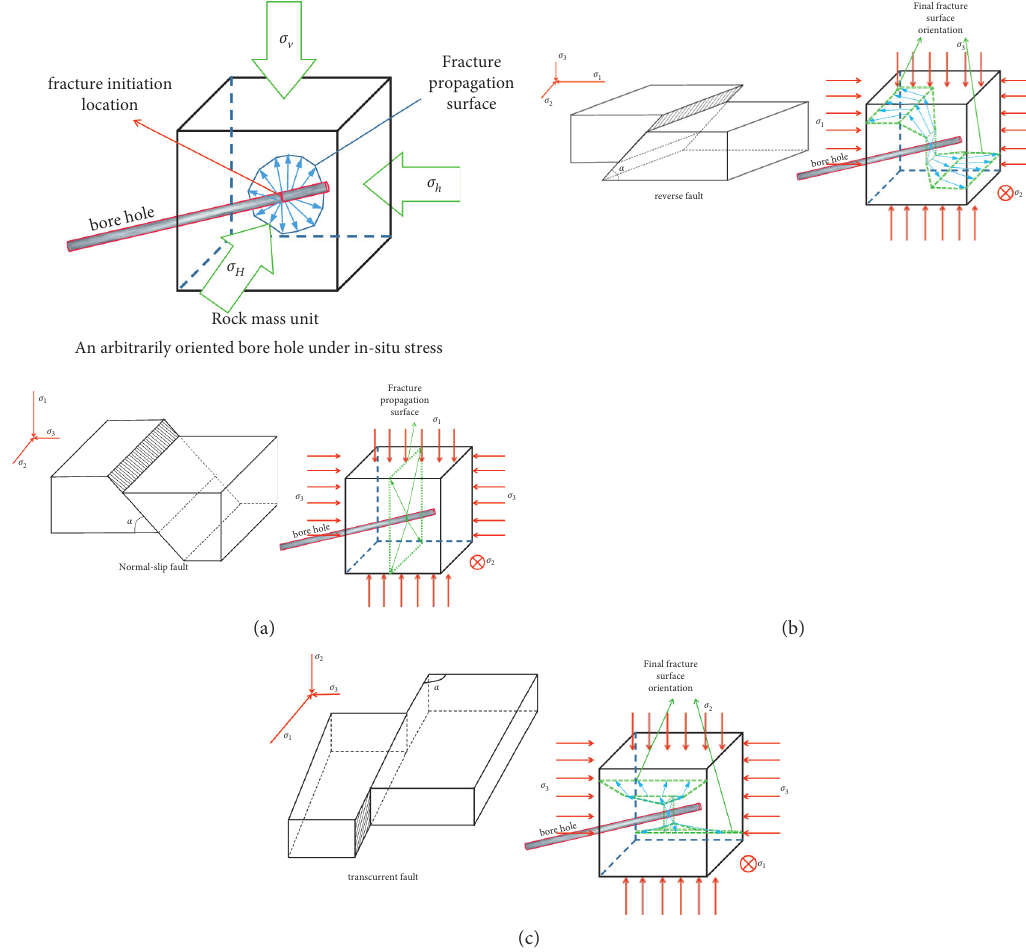
Figure 6: Reorientation effect of in situ stress on fracture propagation. (a) Normal-slip fault fracture propagation. (b) Reverse fault fracture propagation. (c) Transcurrent fault fracture propagation.